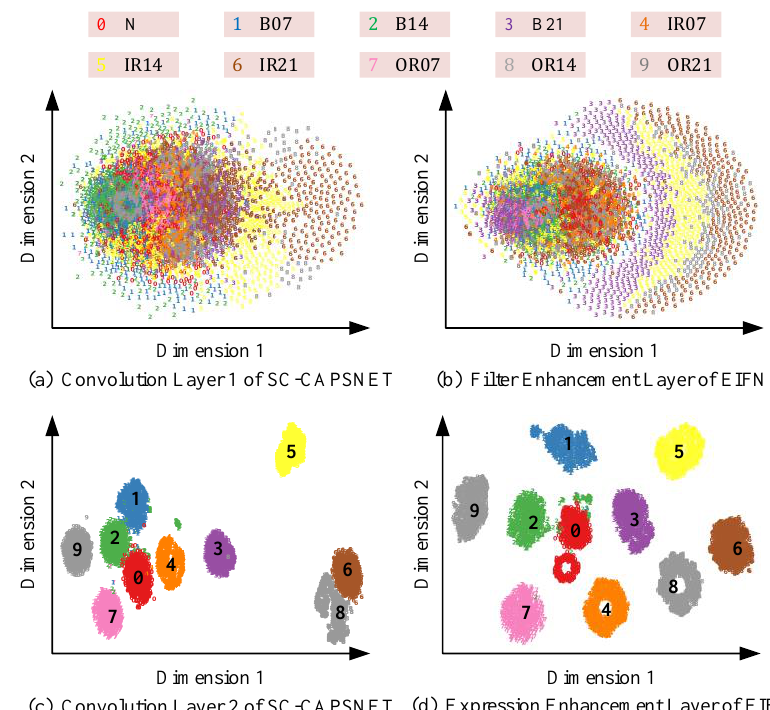
Figure 15. The feature visualization. Here, 0 – 9 indicates different bearing states.